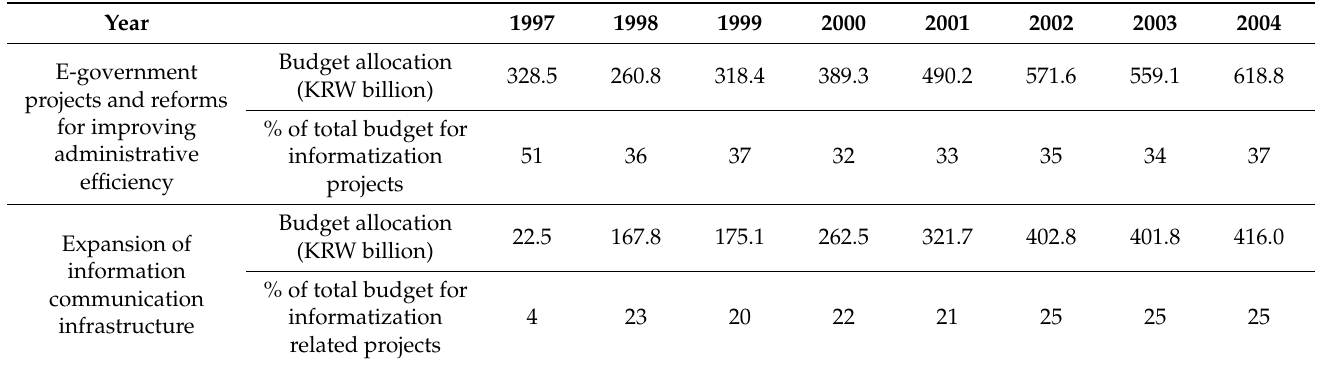
Table 5. The Government Budget for Informatization Projects 1997–2004.